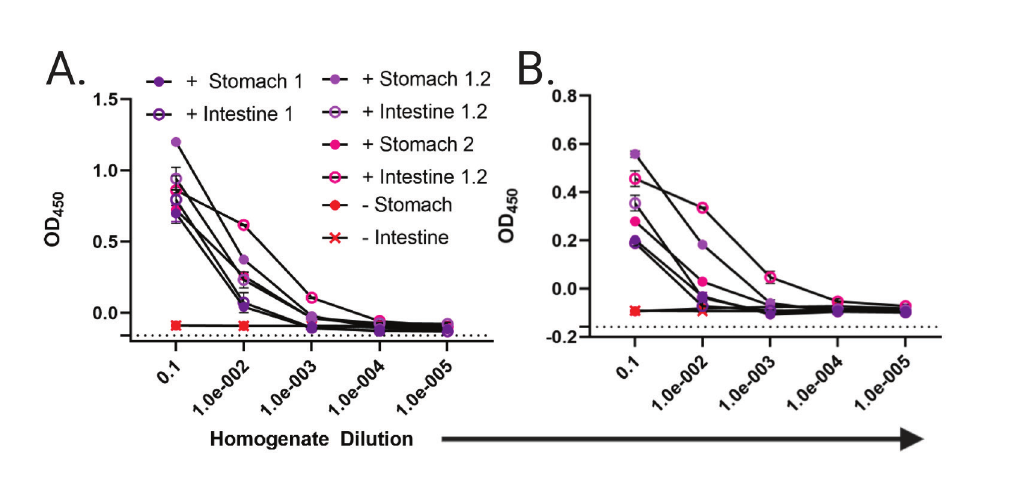
Supplementary Figure 8. IgA in Stomach and Intestinal Homogenates Binds V. cholerae O395 and C6706. Whole cell ELISA with plates coated with either V. cholerae (A) classical Ogawa strain O395 or (B) El Tor Inaba strain C6706. Stomach and intestinal homogenates were diluted 1:10, and then 1:10 across the plate. Only homogenates from pups fed by ZAC-3 hIgA positive dams exhibit above background binding to whole V. cholerae cells. Labels are the same as in Figure S7. Again, homogenates from 1 pup fed from a WT dam were included as a reference. Each individual ELISA was conducted once with 2 technical repli-